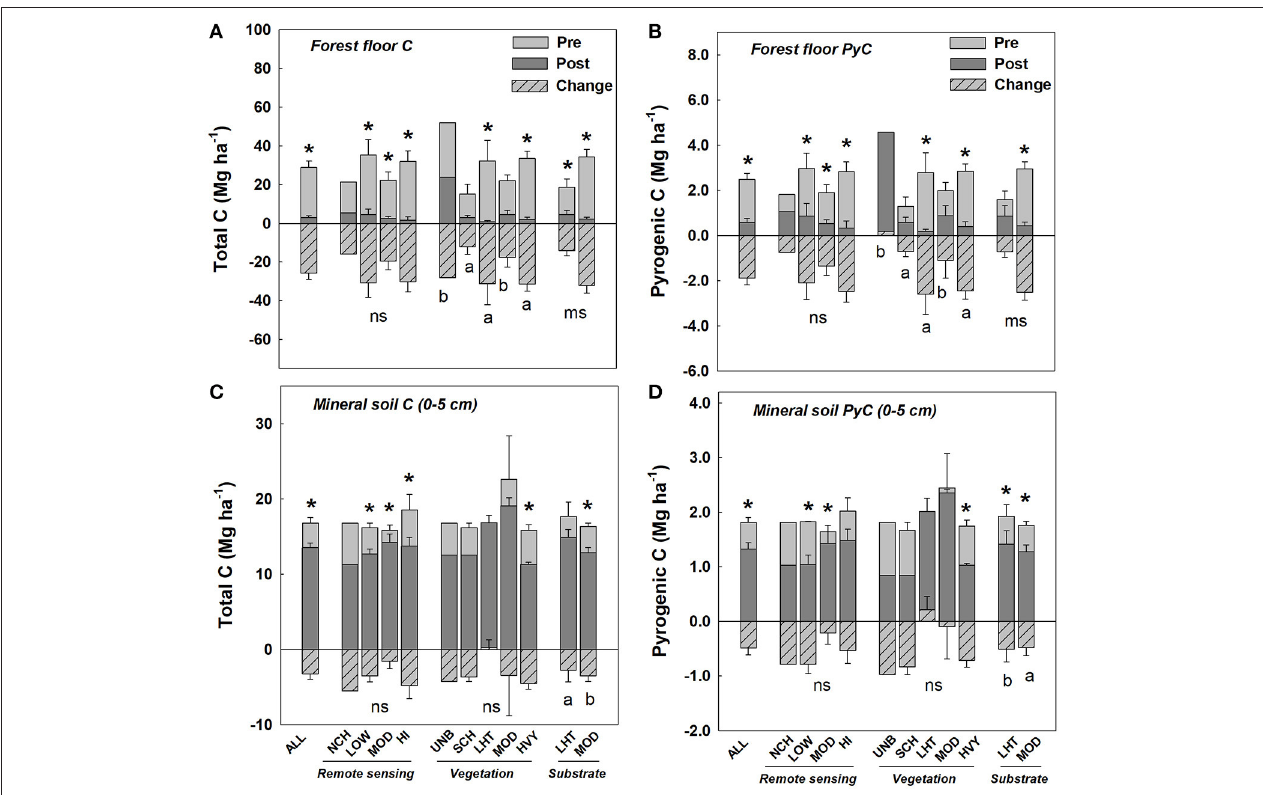
FIGURE 5 | Mean ( ± s.e.) total C and PyC stocks (Mg ha − 1 , estimated as PyC CTR via chemical oxidation) for forest floor (A,B) and mineral soil (C,D) , for pre-fire and post-fire measurements, and calculated differences between pre- and post-fire measurements, shown for overall severity levels (ALL) and for plots classified by three fire severity classification systems. Severity abbreviations follow those given in Figure 3 . Asterisks (*) indicate significant differences between pre- and post-fire measurements, within severity level. Lowercase letters below the zero line indicate significant differences in the change between pre- and post-fire measurements (hatched bars) among severity levels within classification system; ns indicates no significant differences ( p < 0.05) and ms indicates marginal significance ( p = 0.08 for forest floor C, and p = 0.07 for forest floor PyC). Differences among severity levels for pre-fire and for post-fire measurements are described in the